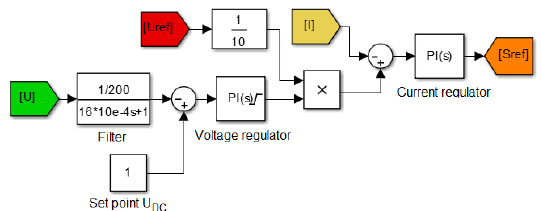
Fig. 4. Simulation model of the control system of one-phase full bridge rectifier with current modulator.